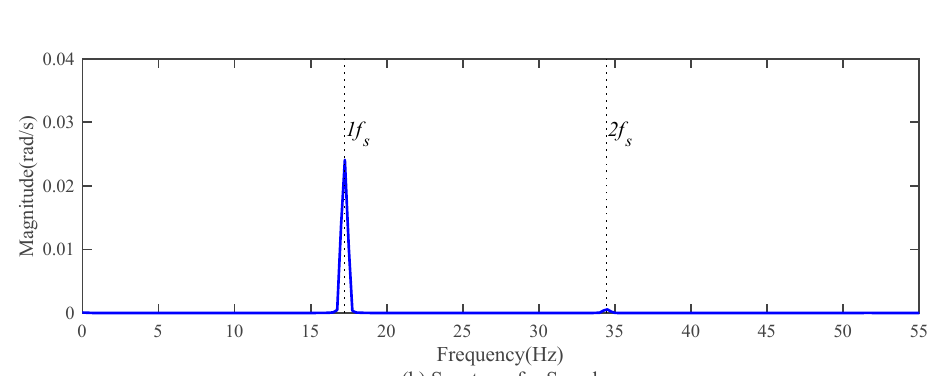
(b) Spectrum for Speed Figure 8. Spectra of current ( a ) and speed ( b ) for spindle rotational fluctuation.